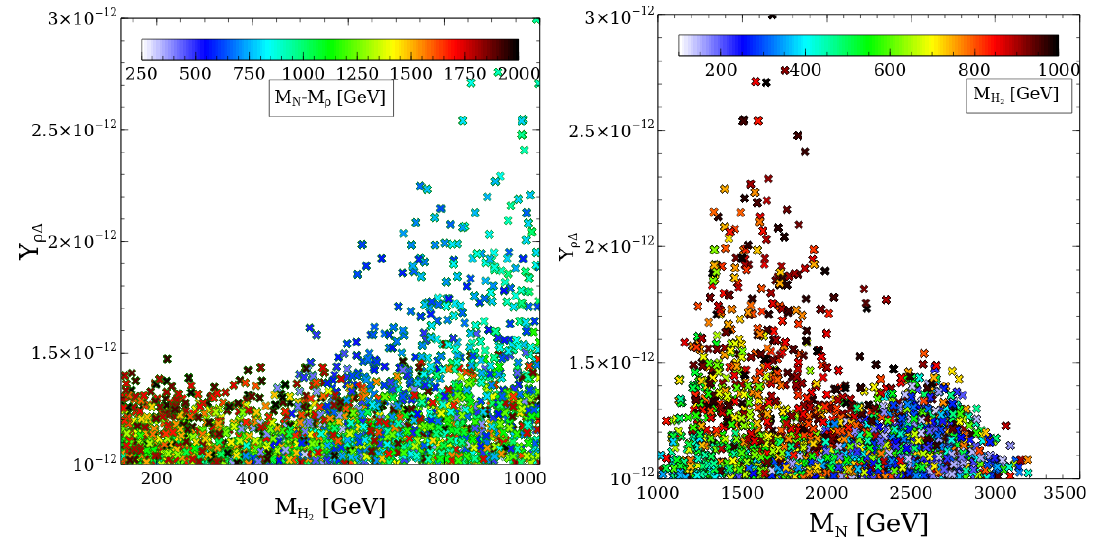
− Y ρ ∆ plane (LP) and in the M N − Y ρ ∆ plane (RP). The 2 and M , respectively. All the points in LP N − M ρ H 2